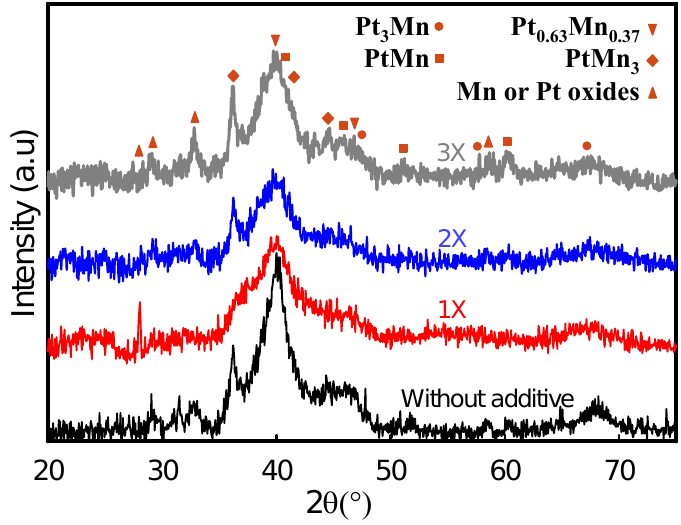
Figure 3. XRD analysis of the samples, which were prepared in the presence and absence of sodium citrate.